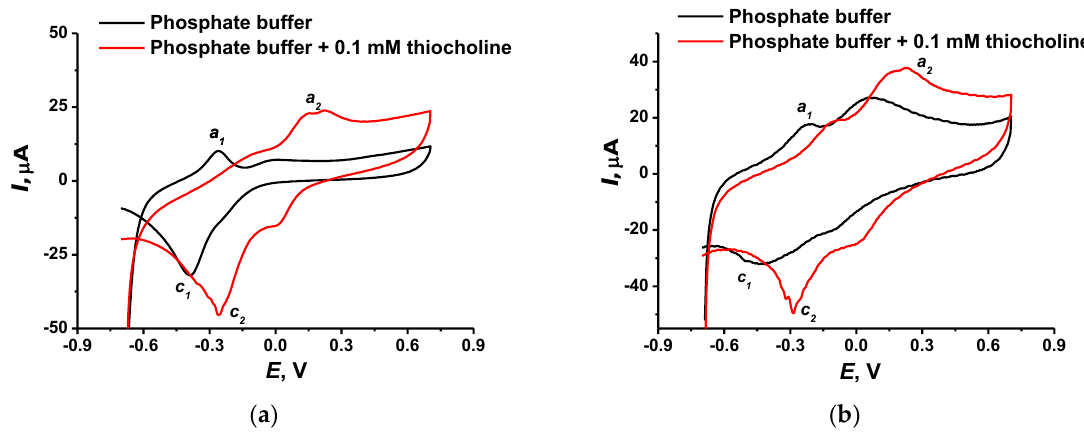
Figure 5. Cyclic voltammograms were recorded on a glassy carbon electrode covered with CB and adsorbed P[5]A ( a ) without and ( b ) with electropolymerized MB and thionine. Recorded in 0.01 M phosphate buffer + 0.1 M KCl containing 0.1 mM thiocholine. Measurements at pH = 7.0, 100 mV/s.